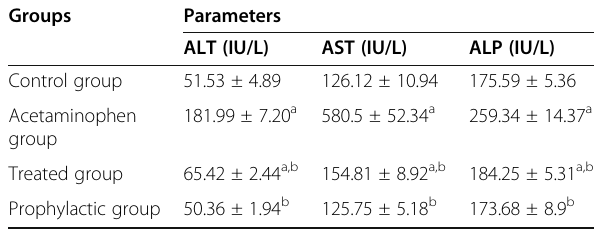
Table 3. Recovery towards normalization of the